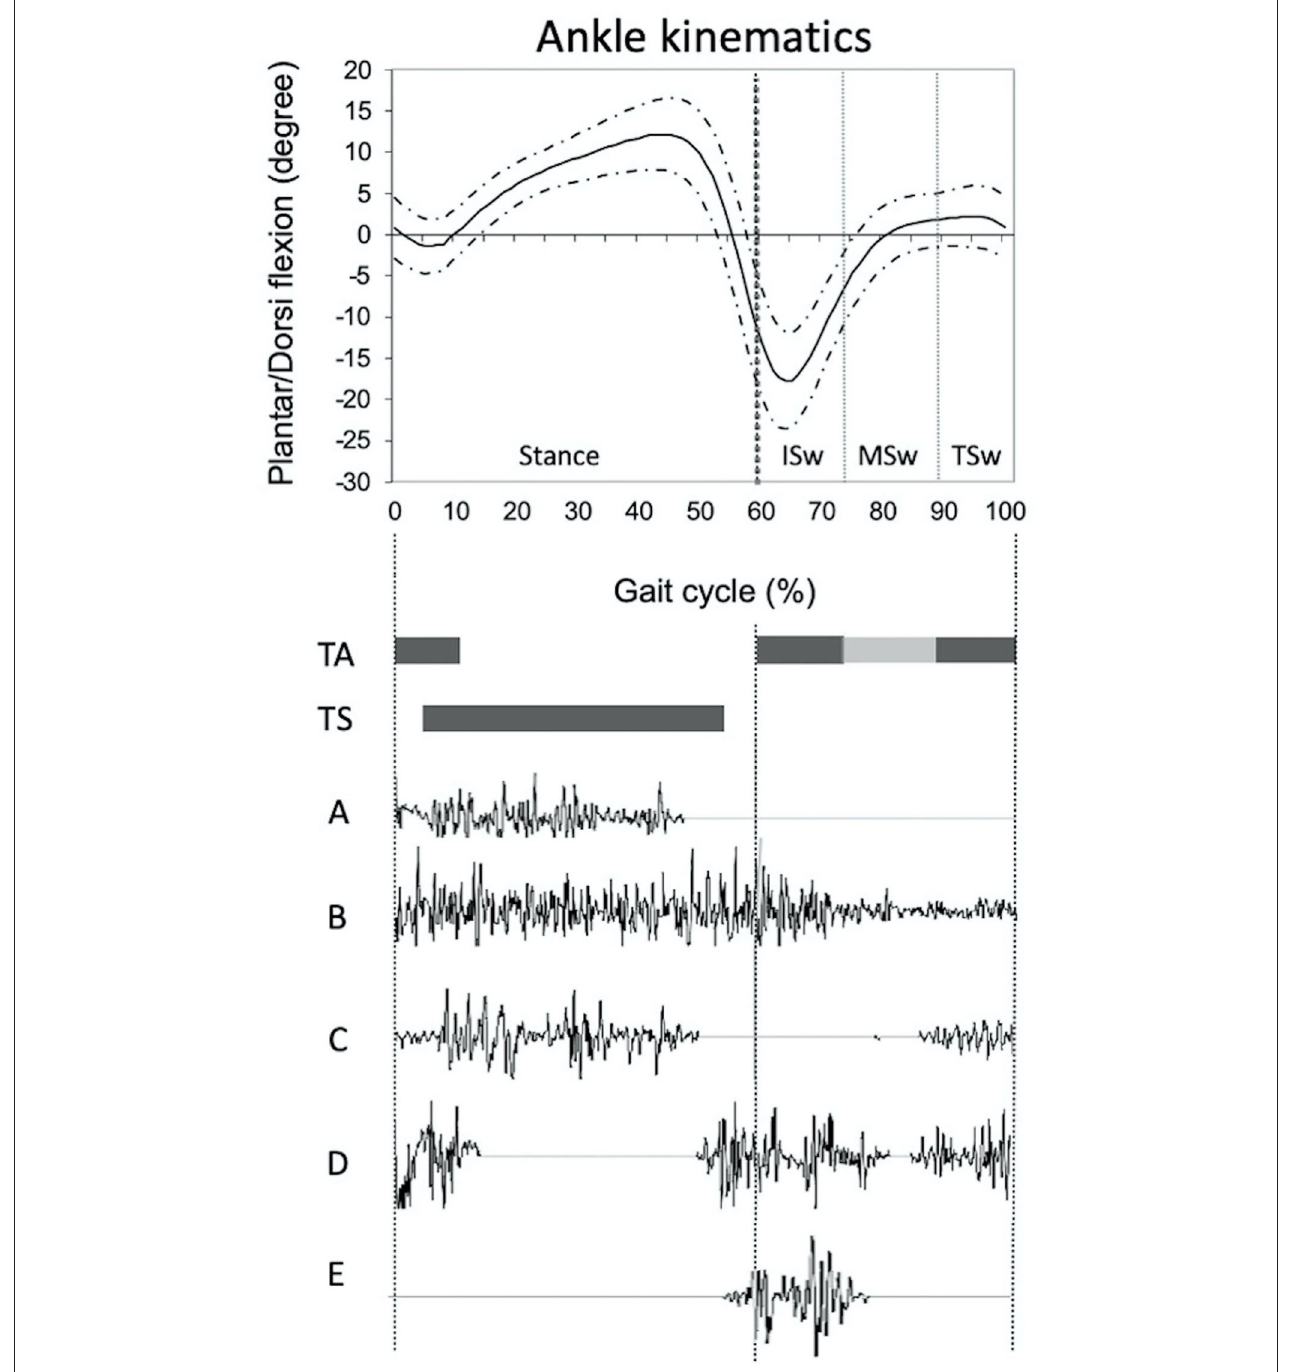
FIGURE 2 | Illustration of ankle physiological kinematic curve (mean value, continued curve ± one standard deviation, dotted curve) and physiological timing of activation (black cases) of tibialis anterior and triceps surae muscles. Description of the different EMG patterns of triceps surae (A–C) and tibialis anterior (D,E) : (A) Physiological, no activation in swing phase; (B) Overactivity during initial swing phase; (C) Overactivity during terminal swing phase; (D) Physiological activation with activation in the swing phase, before the heel strike and prolonged at the beginning of the stance phase; (E) Abnormal pattern characterized by a loss of second activation. ISw, initial swing; MSw, mid swing; TA, tibialis anterior; TS, triceps surae; TSw, terminal swing.